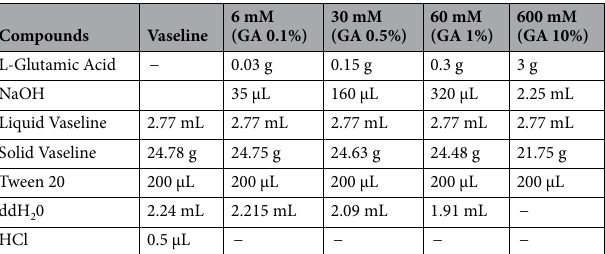
Table 1. Glutamic acid-based creams used in the in vivo experiments. Compound description of Control, GA 0.1%, 0.5%, 1%, and 10% w/w topical